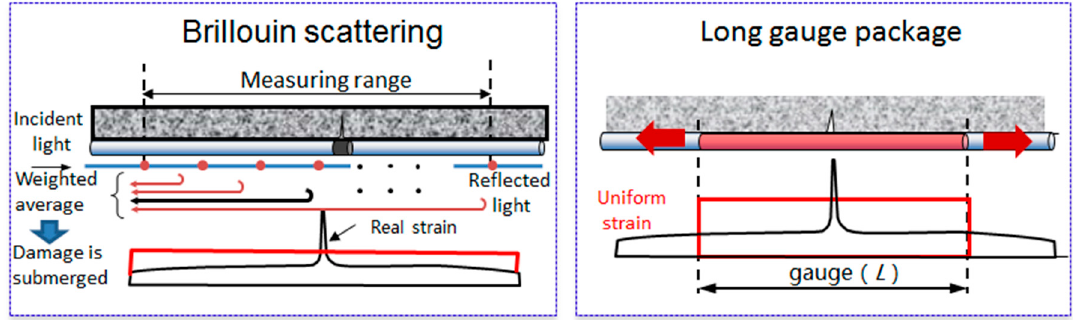
Figure 4. Technique of the long gauge Brillouin scattering sensing: ( a ) Brillouin scattering sensing; ( b ) Long gauge package.